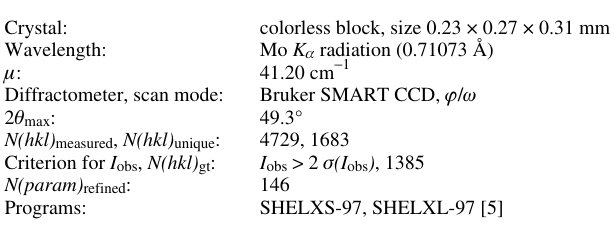
Table 1. Data collection and handling.